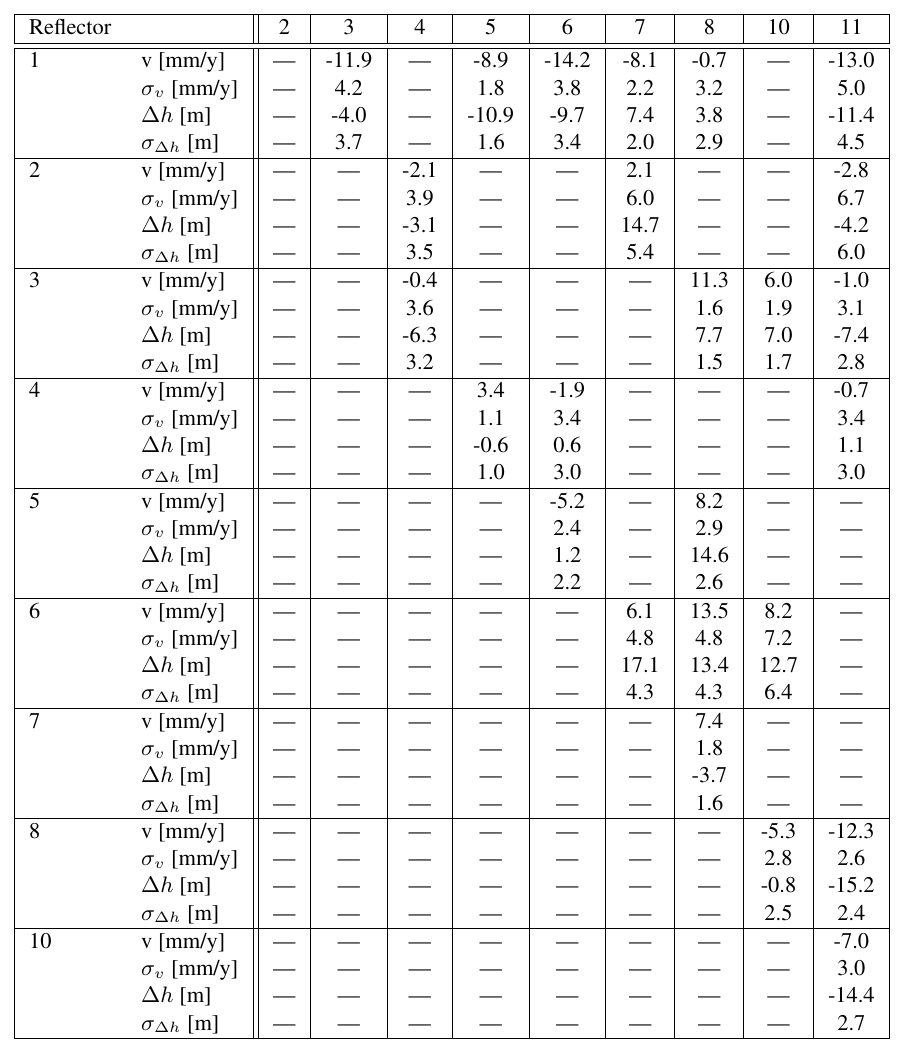
Table 3: Deformation velocities v and their standard deviations σ v , together with height corrections ∆ h and their standard deviations σ ∆ h , computed for all reflector pairs with zero triangular sums (some of them were corrected using the deformation model). be 2 π corrected for more than two interferograms: see